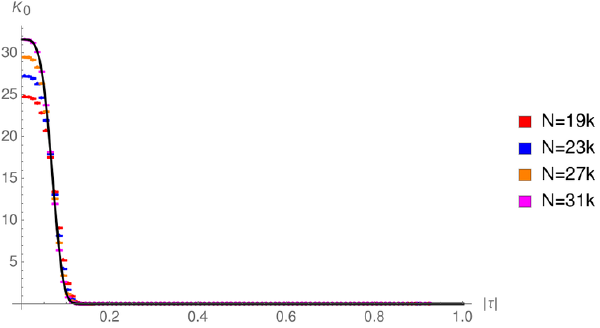
Figure 5. The binned and averaged plot for K